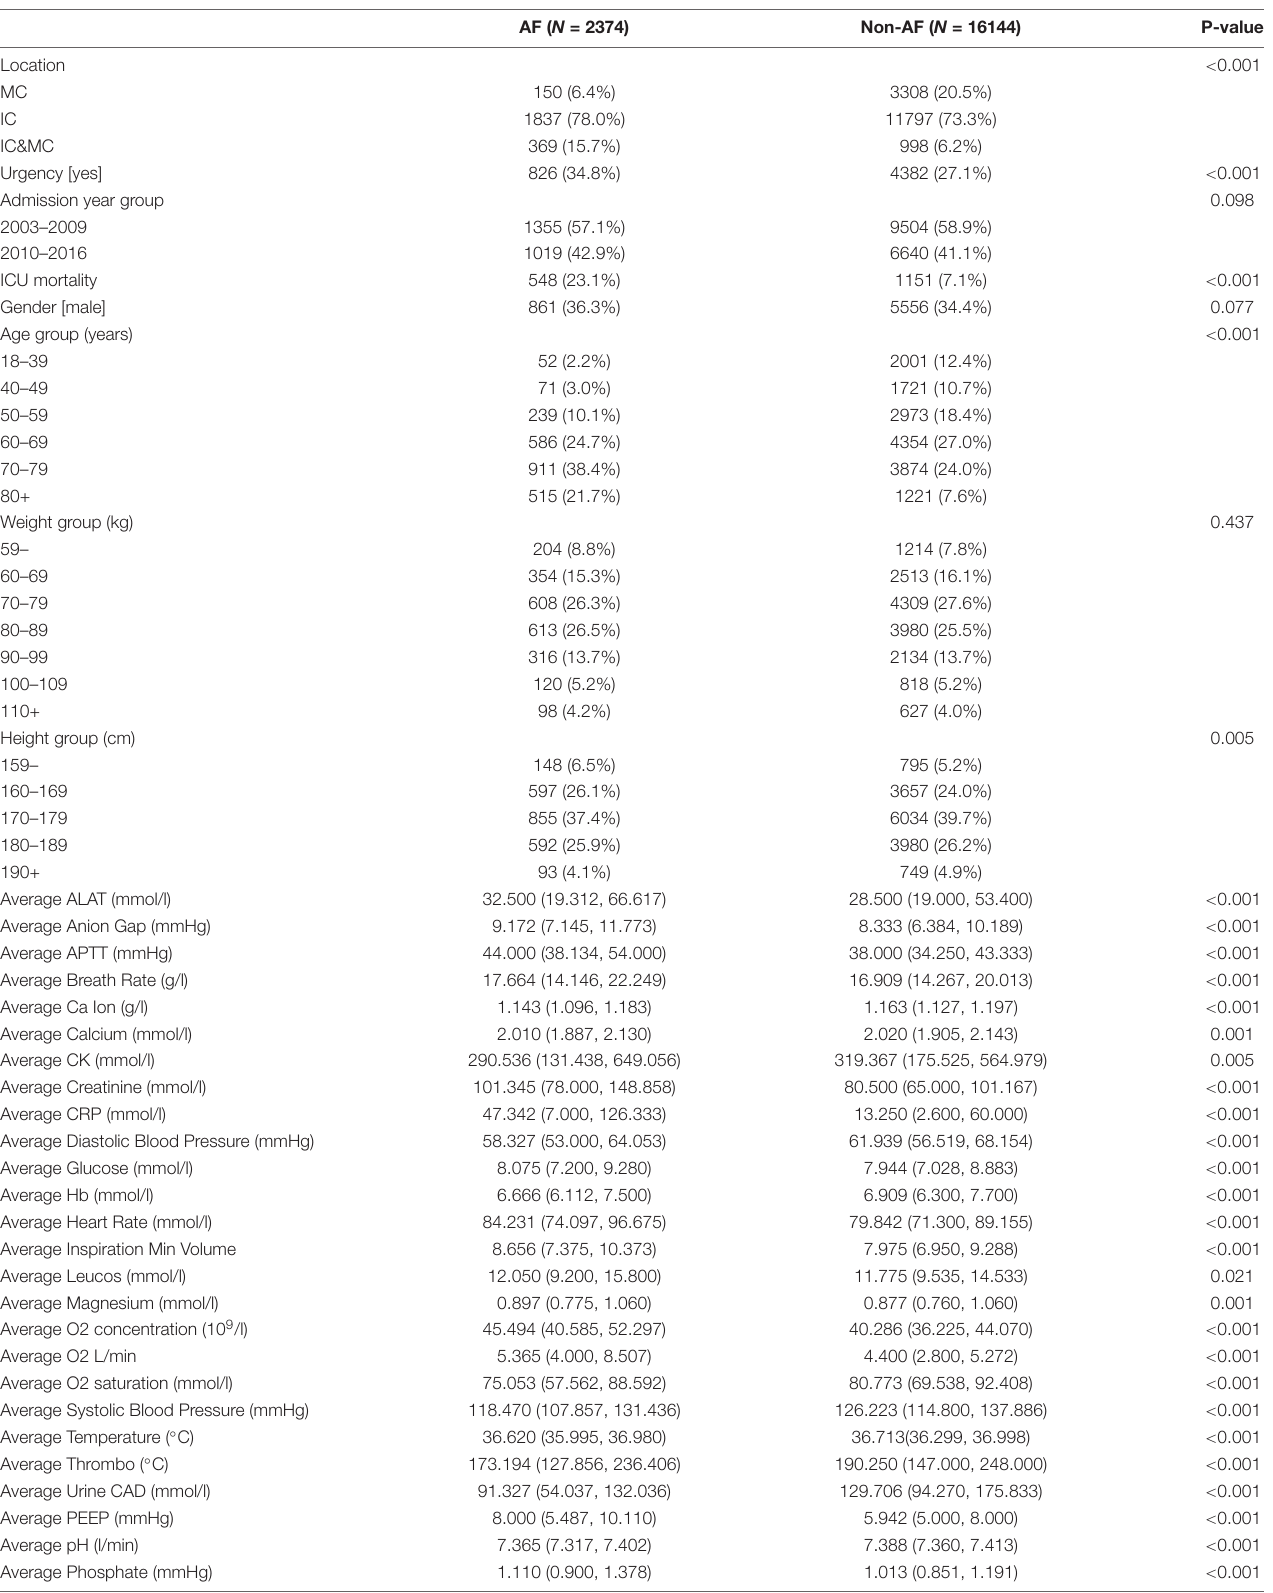
TABLE 1 | Demographics, vital signs, and routine prognostic scores used for